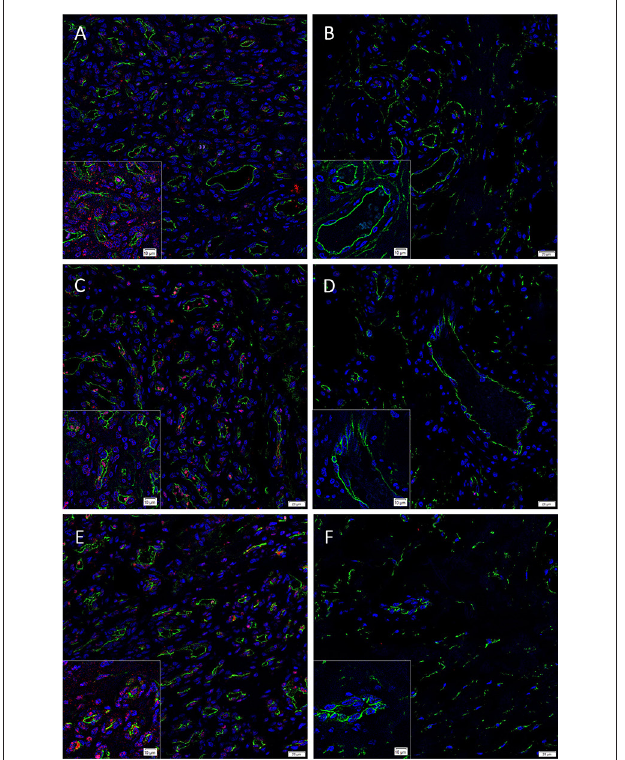
Figure 1 | Representative immunofluorescence immunohistochemical - stained sections of proliferating (a, c,e) and involuted (B, d, F) IH samples demonstrating expression of pSTAT1 (a, B , red ) , pSTAT3 ( c, d , red) and pSTAT5 (e, F , red ) , double-stained with CD34 (a–F , green ) . There was reduced or no expression of these proteins in involuted IH samples (B, d and F) . Cell nuclei were counter-stained with 4 ′ , 6-diamidino-2- phenylindole (blue). Scale bars: 20 µm. Inserts: magnified views.